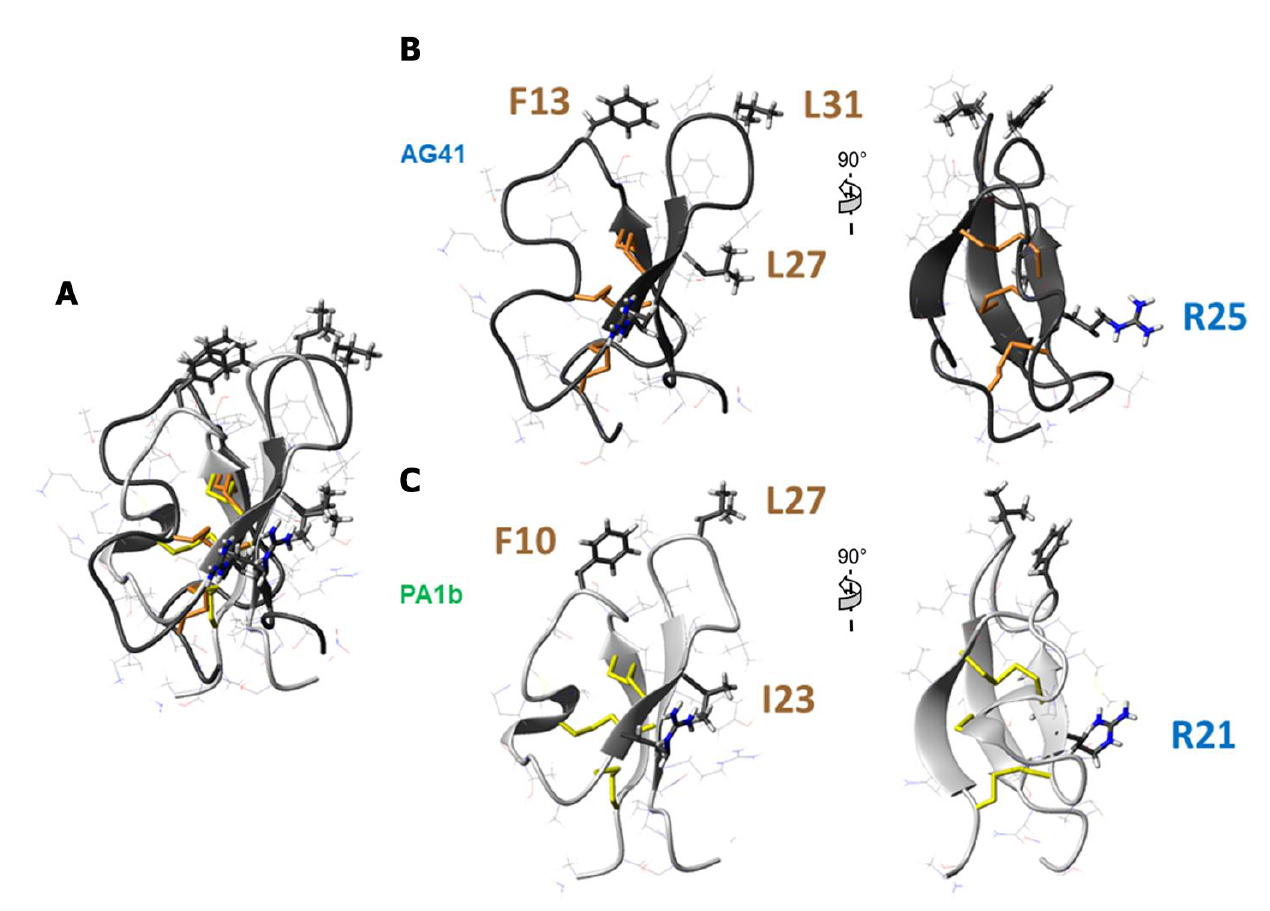
Figure 5. Key residues for PA1b and AG41 entomotoxicity. ( A ) Superposition of ribbon representations of AG41 (dark grey, orange disulfide bridges) and PA1b (light grey, yellow disulfide connectivities) with key residues represented in sticks, fitted on the strands 2 and 3 that are involved in the β -hairpin. ( B ) Ribbon representation of AG41 structure showing the key residues F13, R25, L27 and L31 for AG41 bioactivity in sticks. ( C ) Ribbon representation of PA1b structure displaying the key residues F10, R21, I23 and L27 for PA1b bioactivity in sticks.